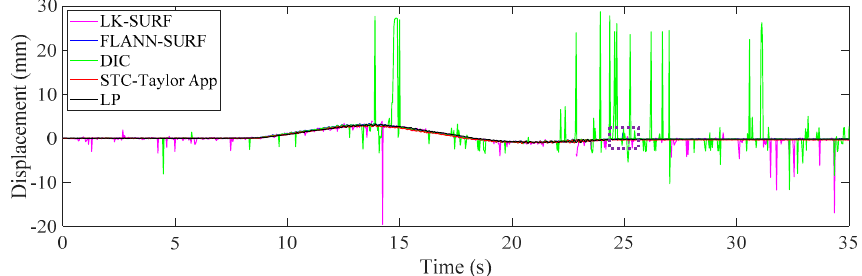
Figure 19. Case 3 (fog interference): displacement time histories of P1 from different methods. Sensors 2019 , 19 , x